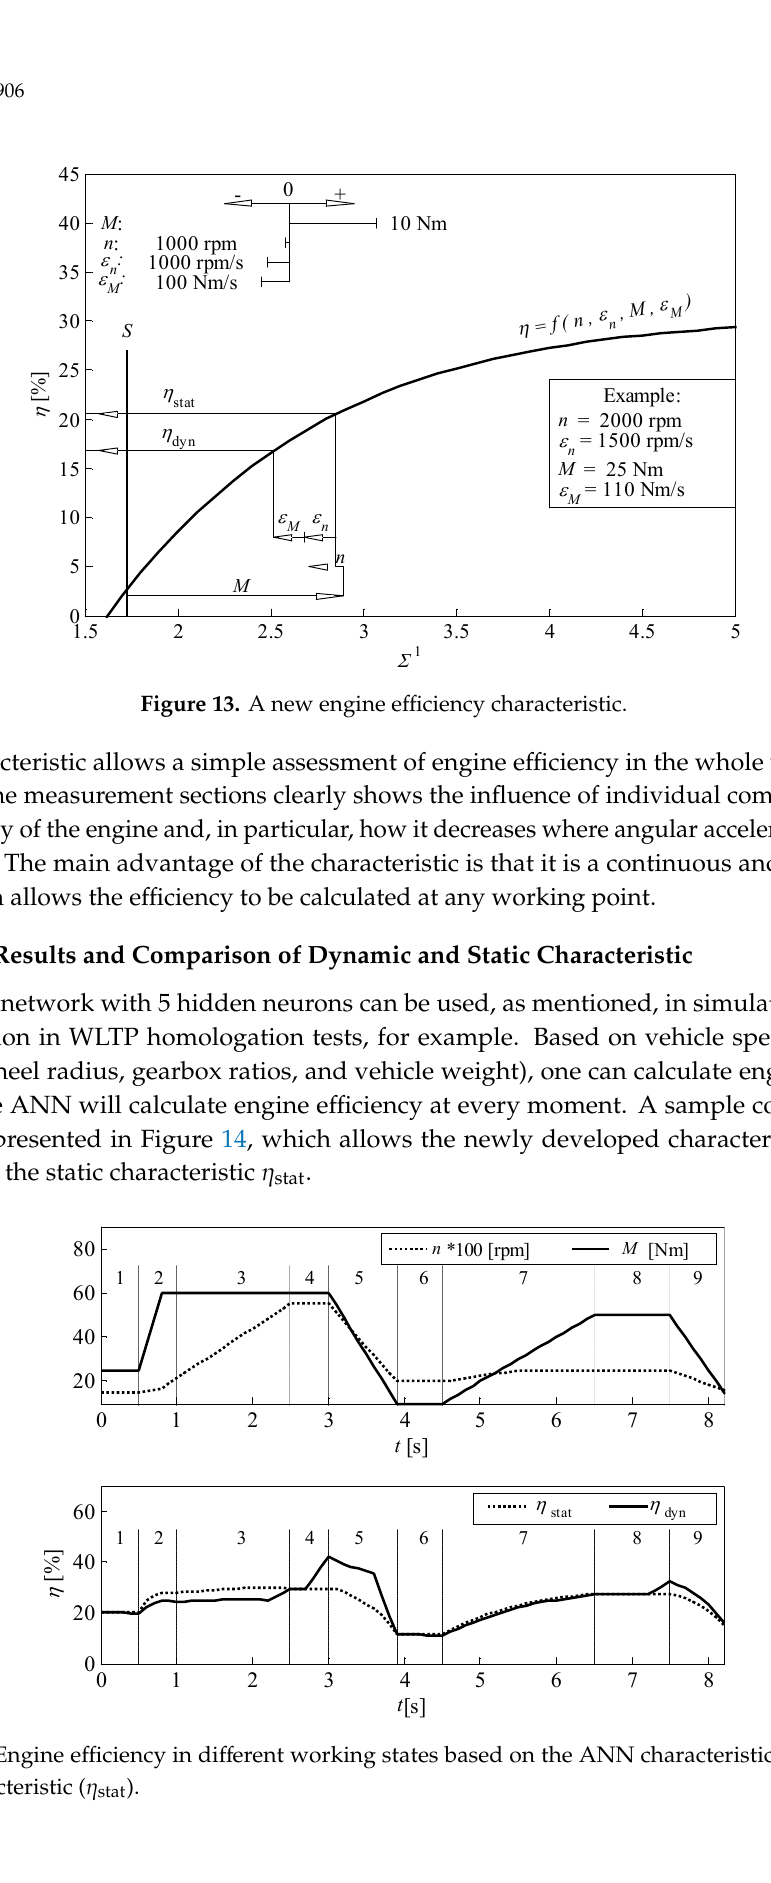
Figure 12. Operations on the logsig function inside the AN.